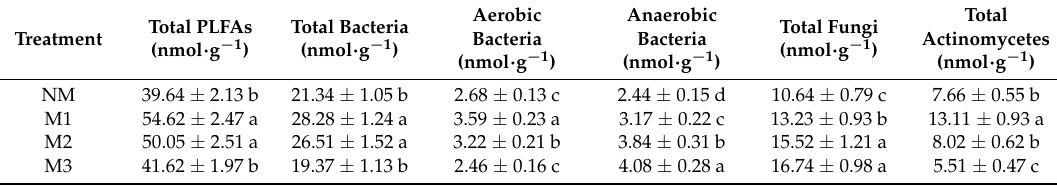
Table 4. Mean total microbial phospholipid fatty acids (PLFAs) in P. edulis stands of different mulching